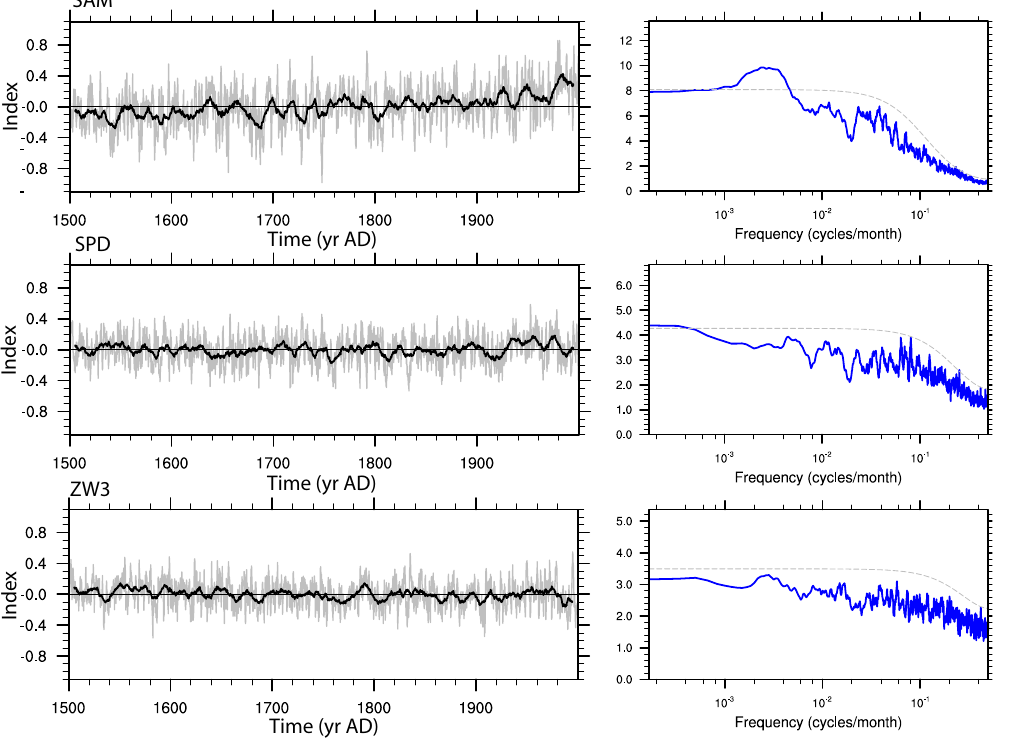
Fig. 4. Time series (black) of the monthly (a) SAM index, (b) SPD index and (c) ZW3 index calculated for transient simulations shown as the ensemble mean smoothed with a 12-month running mean (grey) and an 11 × 12-month running mean (black). The corresponding spectrum is shown on the right hand side (blue) with the dashed lines indicating the 95% confidence levels of the theoretical Markow red noise spectrum.